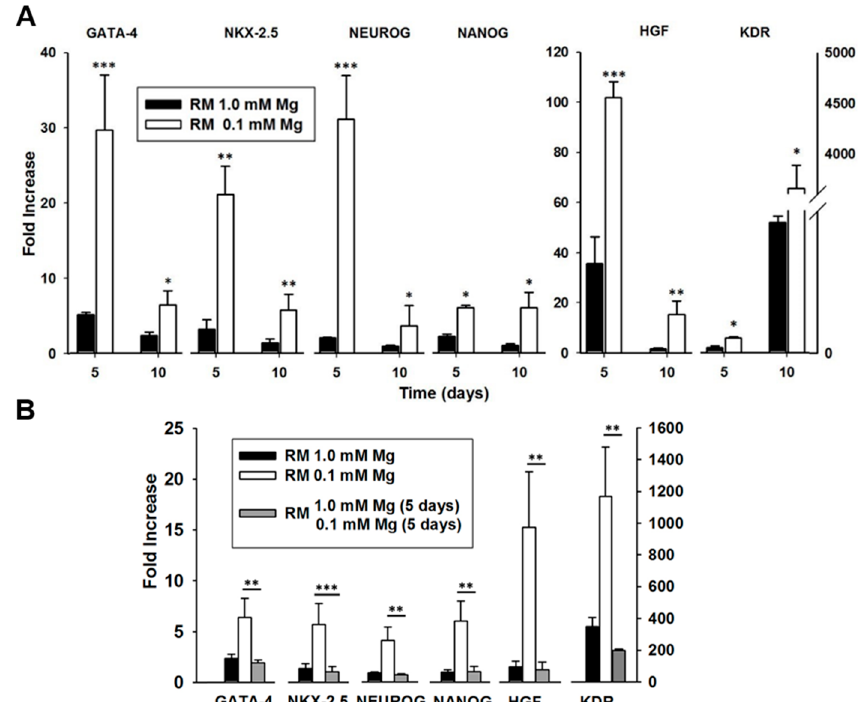
Figure 1. Effect of Mg withdrawal and re-supplementation on gene expression in adipose-derived mesenchymal stem cells (AD-MSCs). ( A ) Expression of multilineage markers in AD-MSCs treated in reprogramming medium (RM 1.0 mM Mg, black bar), or in Mg-deficient medium (RM 0.1 mM Mg, white bar). From the left: GATA-4 , NKX-2.5 , NEUROG , NANOG , HGF , KDR . All the values were normalized with respect to their untreated controls. * p < 0.05, ** p < 0.01, *** p < 0.001. ( B ) Expression of GATA-4 , NKX-2.5 , HGF , NEUROG , NANOG and KDR in cells cultured in complete RM (black bar) or in Mg-deficient medium (white bar) for 10 days. Some samples were kept in Mg-deficient medium for 5 days and then supplemented with 1 mM Mg for additional 5 days (grey bar). All the values were normalized with respect to their untreated controls (i.e., without the reprogramming cocktail). The results are the mean of three experiments carried out in triplicate. ** p < 0.01, *** p < 0.001.